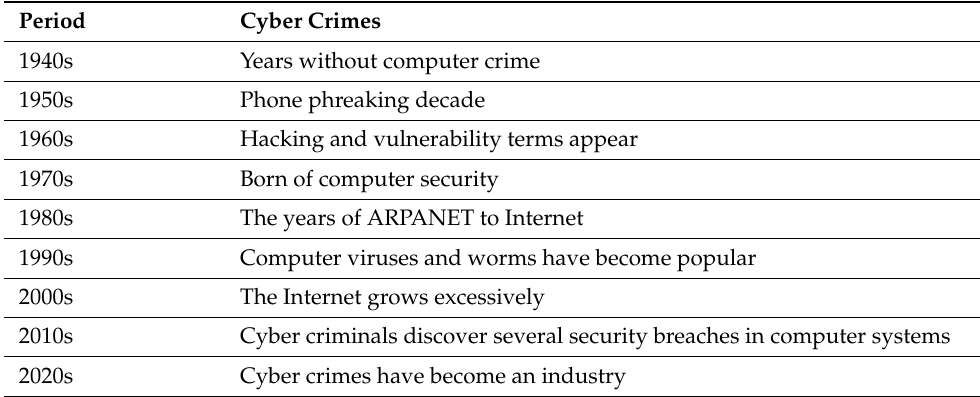
Table 2. The classification of cyber crimes over the